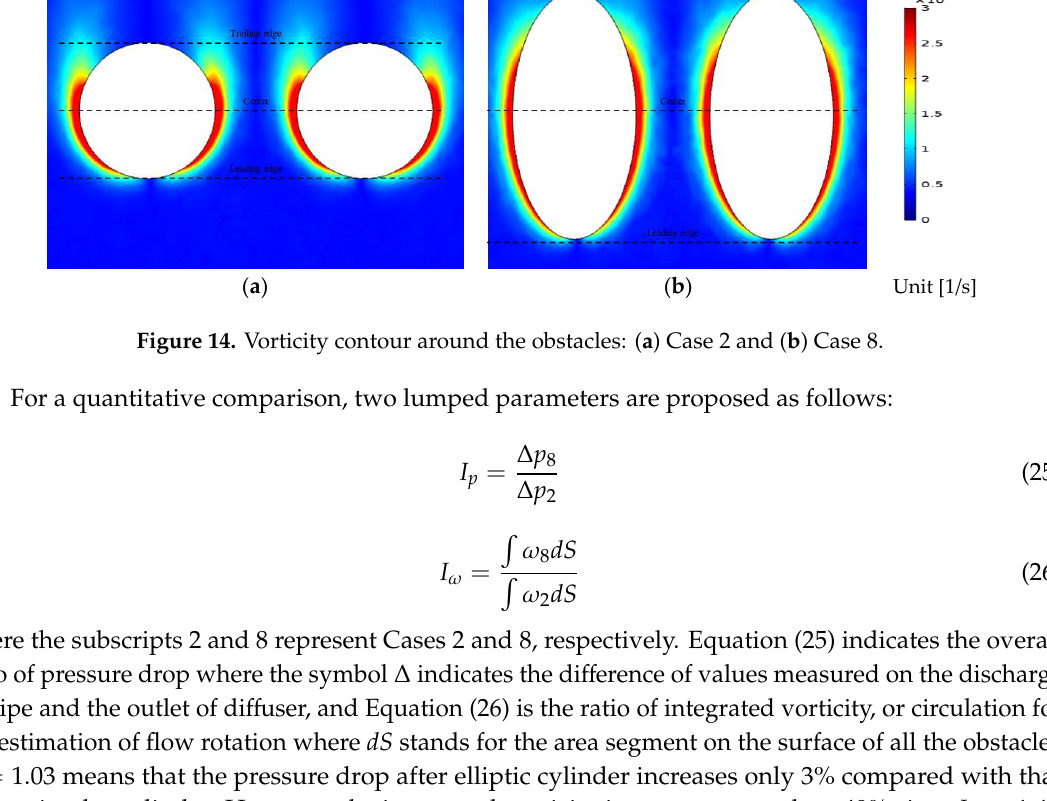
Figure 13. Velocity contour at the diffuser: ( a ) Case 2 and ( b ) Case 8.